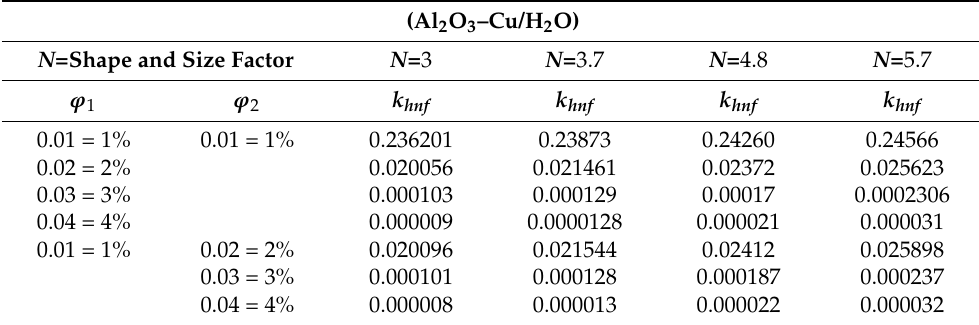
Table 7. Numerical results on the thermal conductivity k hnf of HN fd given different shape and size